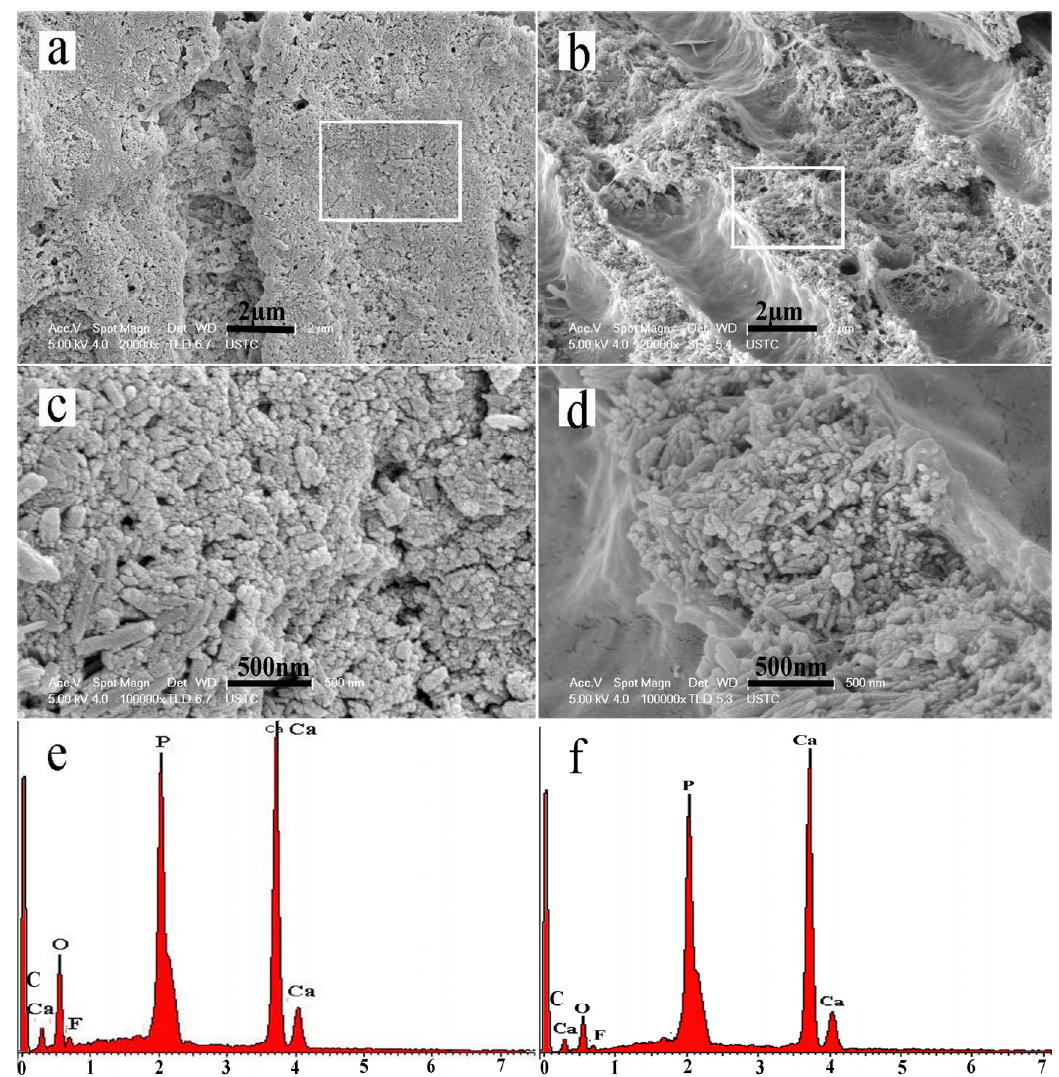
Figure 4. SEM micrographs of well ‐ remineralized intertubular dentin after six remineralization cycles. ( a ) The intertubular dentin near the dentin surface; ( b ) The intertubular dentin in the interior of the dentin slice; ( c , d ) Magnified micrograph of the region denoted by a rectangle in ( a ) and ( b ), respectively; ( e , f ) Dispersive X ‐ ray spectroscopy (EDX) of the remineralized intertubular dentin in ( b ) and ( d ).